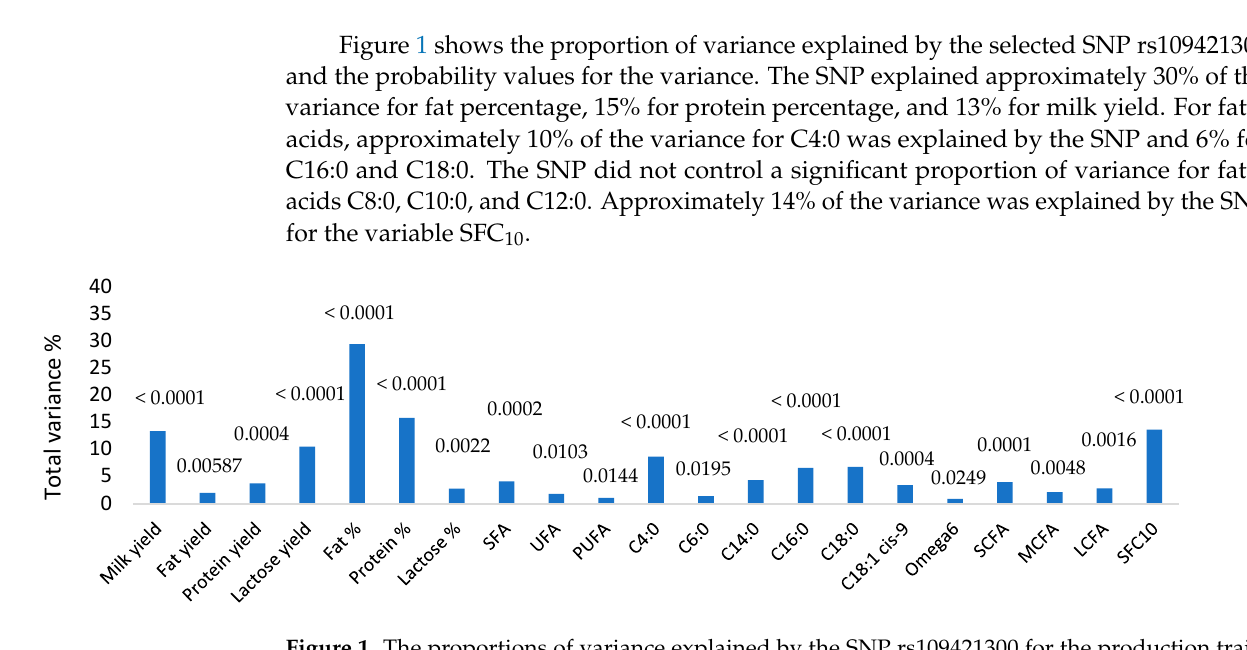
yield; 7 Solid fat content at 10 °C; N is from 3 sampling period (early, mid, and late lactation).